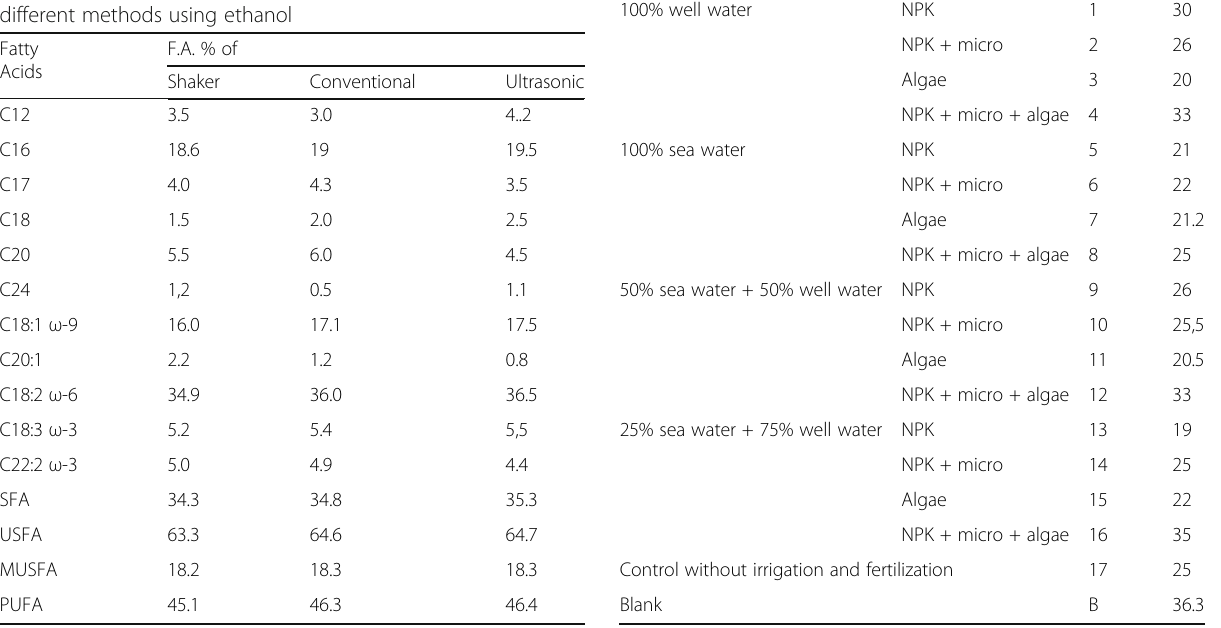
Table 3 Total oil % of S . bigelovii seeds cultivated under different combined treatments Treatments Sample